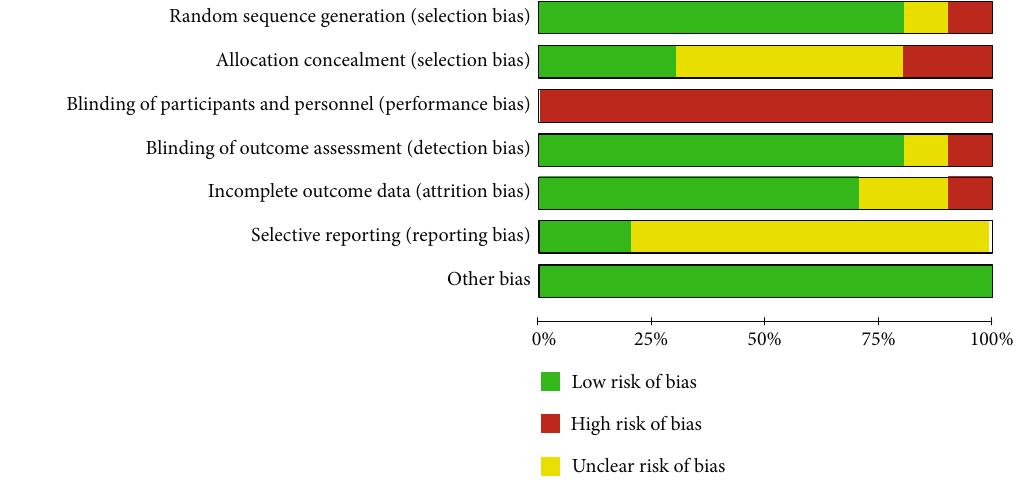
Figure 2: Graph of the risk of bias: percentages across all included